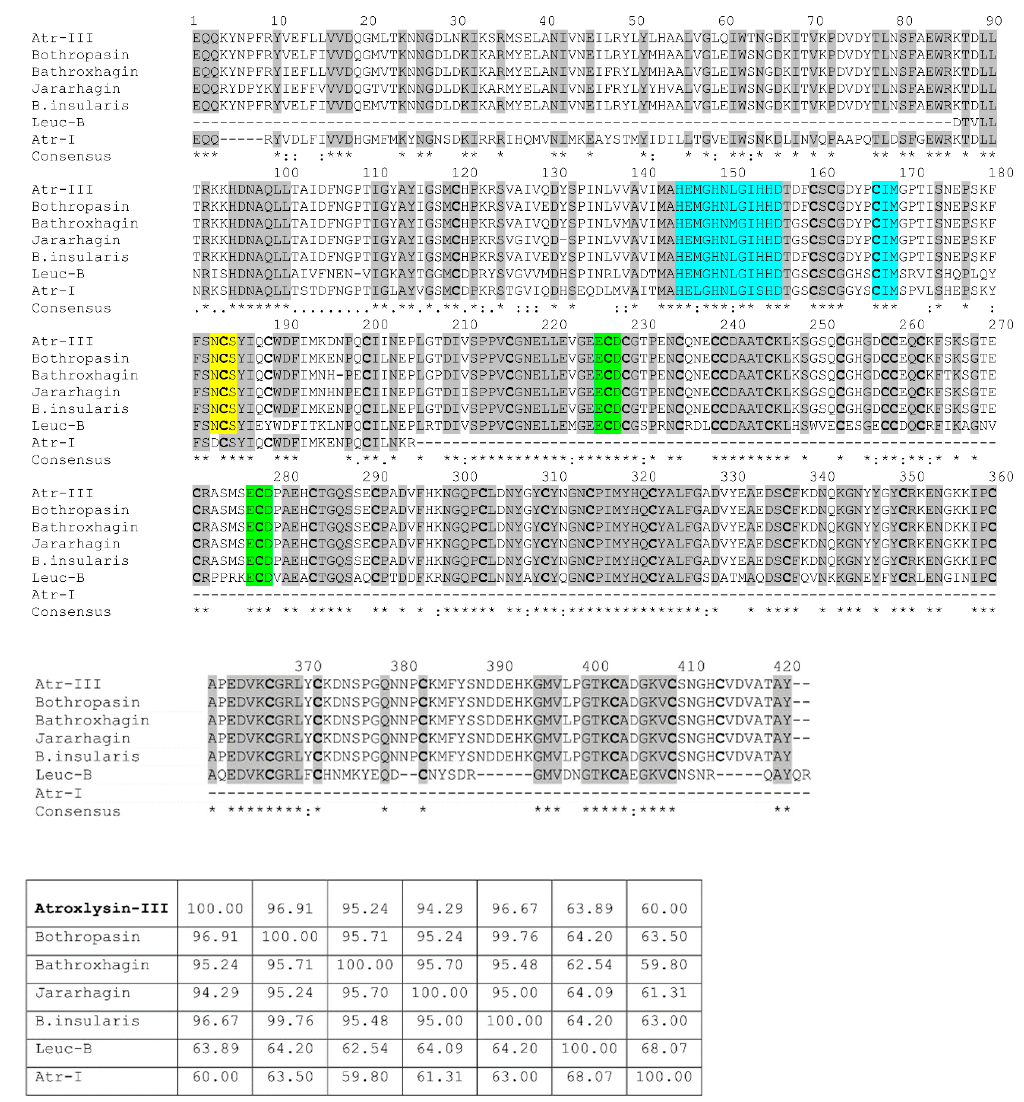
Figure 2. Sequence alignment of Atr-III with other snake venom metalloproteinases (SVMPs) from different pit viper species. The sequence of Atr-III is aligned corresponding to those of the following venom proteins: Bothropasin from B. jararaca (AAC61986), Batroxrhagin from the Brazilian B. atrox (KR632593), Jararhagin from B. jararaca (P30431), B. insularis P-III from B. insularis (AAM09693), Leuc-B from B. leucurus (P86092) and Atr-I, a P-I SVMP from the same B. atrox venom (P85420). Amino acid numbering follows that of Atr-III. Residues are denoted if highly homologous (*) or strongly similar (:). The zinc binding motif (HEGNHLGIHHD) and the methionine 168 of the Met-turn region are invariant and are highlighted in blue. Putative N-linked glycosylation site is bold and boxed in yellow. The cysteine residues are bold and highlighted. Disintegrin-like (ECD) sequences are highlighted in green. Gaps (-) were introduced to optimize the sequence identity. a.a., amino acids. Sequences were aligned using the CLUSTAL W Program.